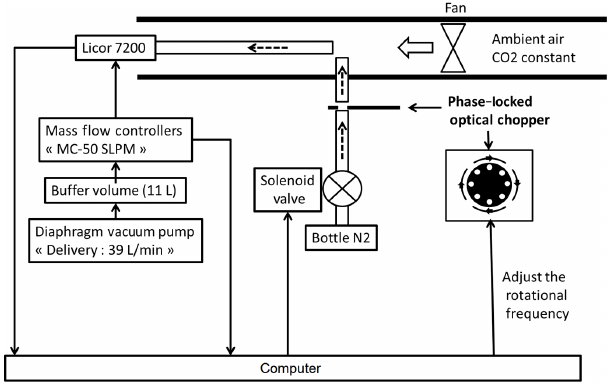
Figure 1. Calibration bench for cut-off frequency determination.